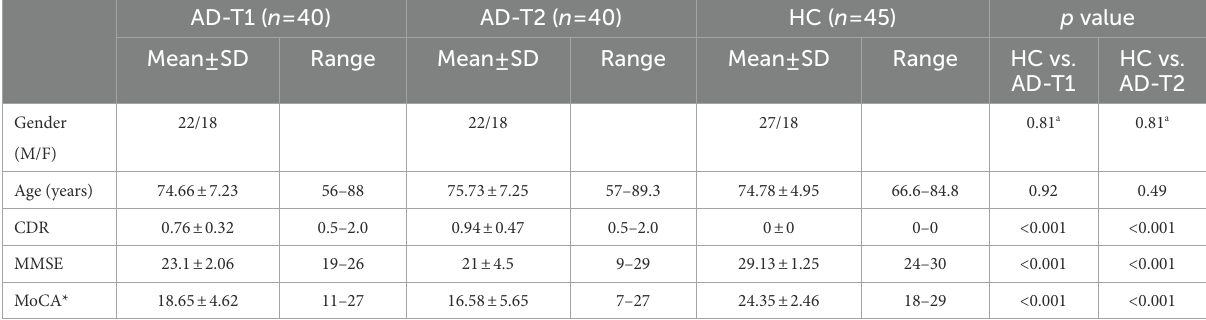
TABLE 1 Demographic characteristics and clinical scores of AD patients at different time points (AD-T1, AD-T2) and healthy controls